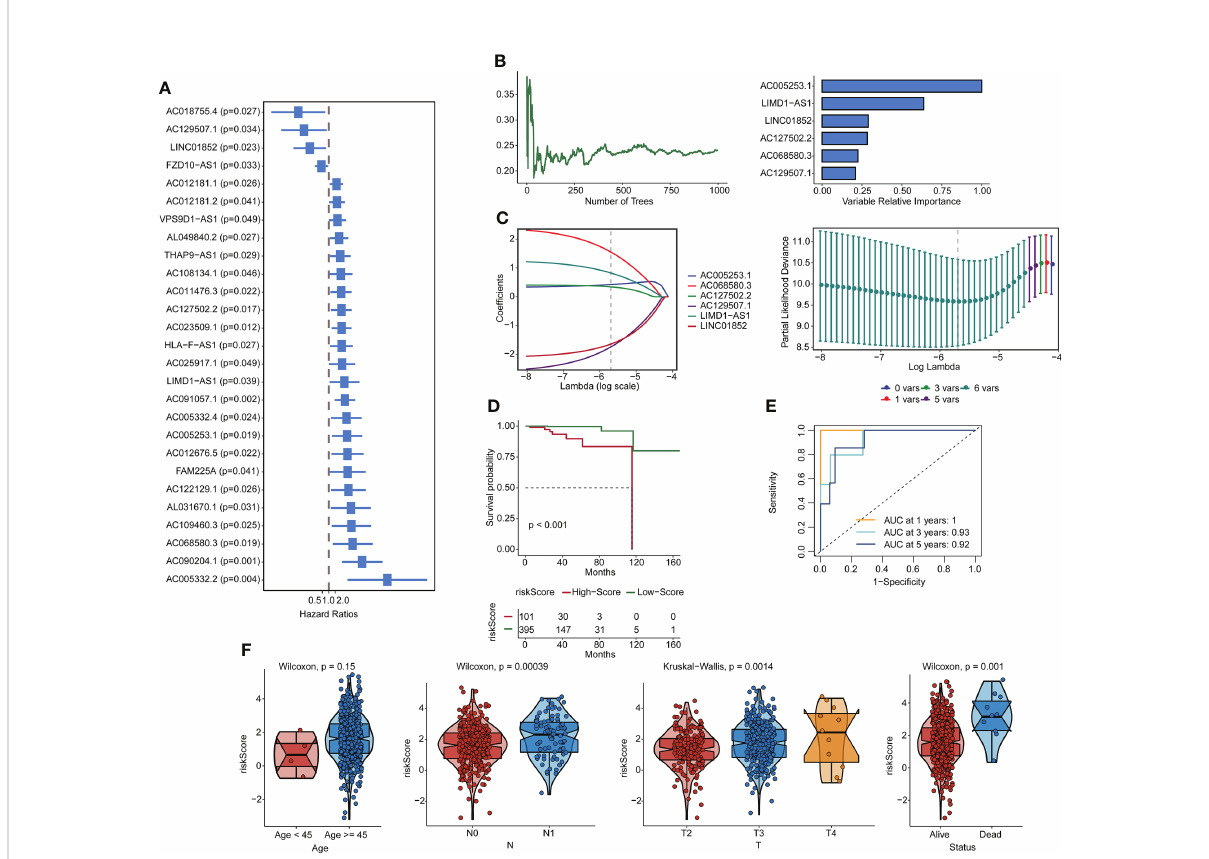
FIGURE 1 Construction of pyroptosis-related lncRNA signatures. (A) Correlation gene screens for genes of univariate signi fi cance. (B, C) Six PRL signatures were constructed through a random forest and Lasso analysis. (D) Survival curves. (E) ROC curves. (F) Clinical feature scores. lncRNA, long non- coding RNA; PRL, pyroptosis-related lncRNA; Lasso, least absolute shrinkage and selection operator; ROC, receiver operating